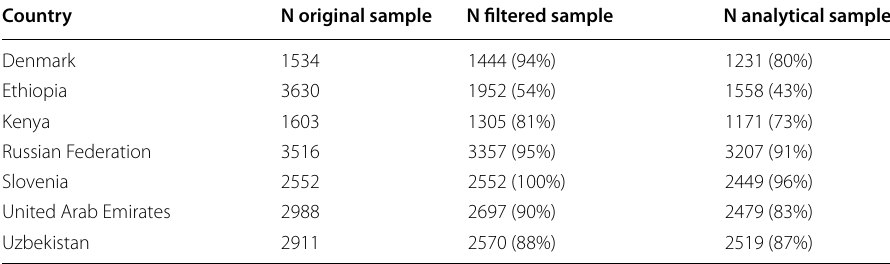
Filtered sample removes students who reported that they did not participate in remote learning during the disruption period. Analytical sample refers to the sample, after filtering, of students with complete cases of the Remote Learning Quality scales. Percentages within parentheses are relative to original sample and are